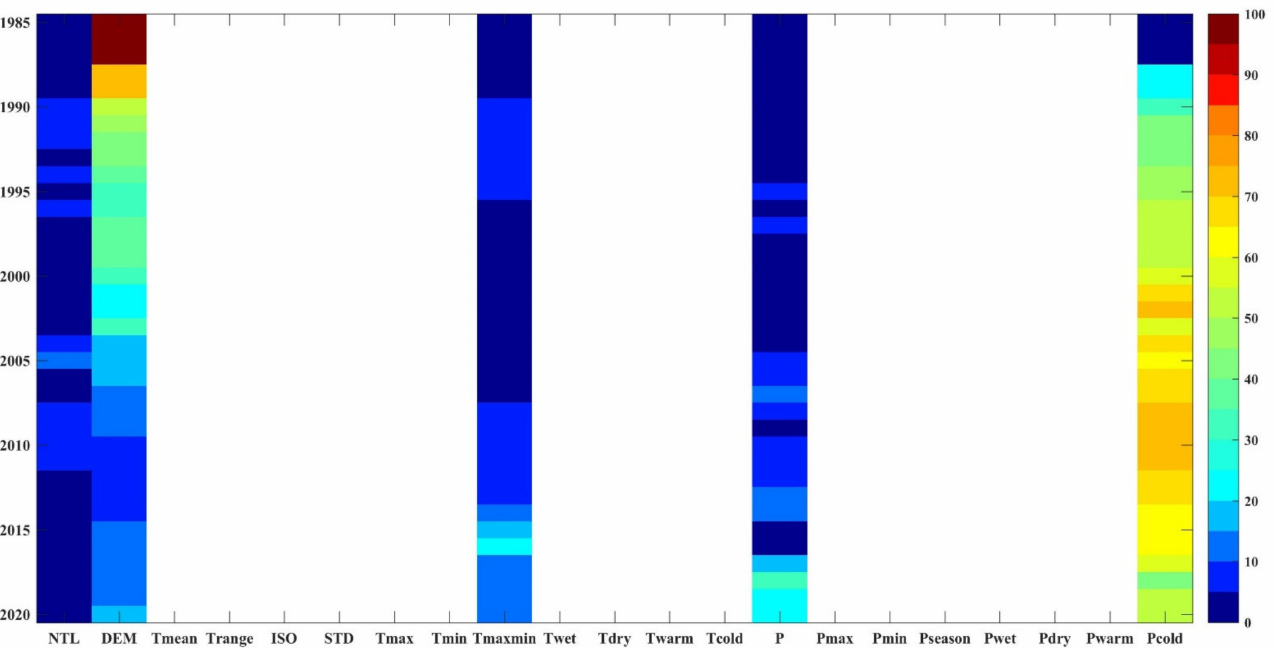
Figure 5. Permutation importance values for long-term environmental factors in the MaxEnt models between 1985 and